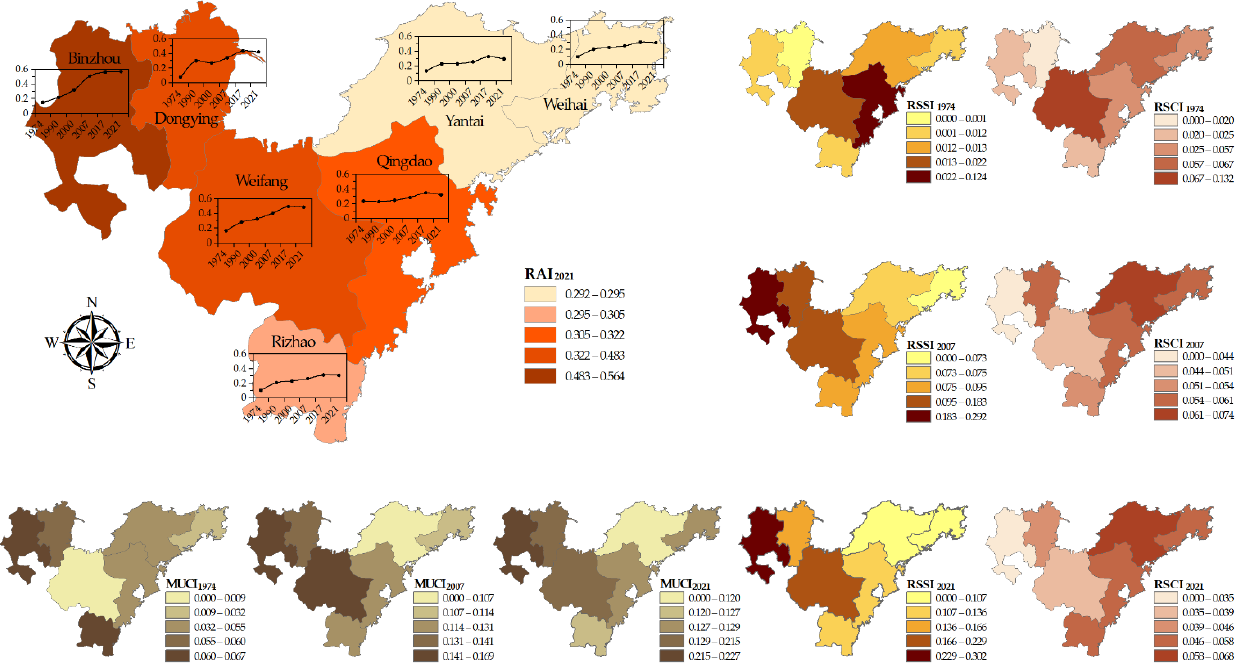
Figure 5. Spatial distribution of sub-indexes in different cities. The structural scale of reclamation index (RSSI), spatial characteristics of reclamation index (RSCI), and coordination of marine utilization index (MUCI) are the weighted values.